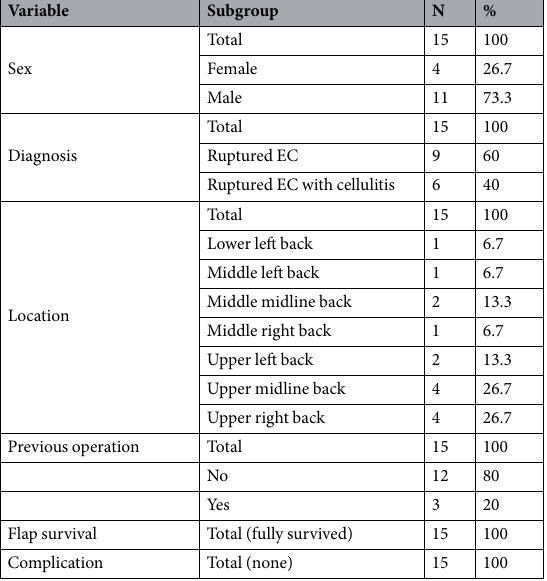
Table 3. Data distribution for categorical variables in patient characteristics. EC, epidermoid cyst; N, sample number; %, percentage.